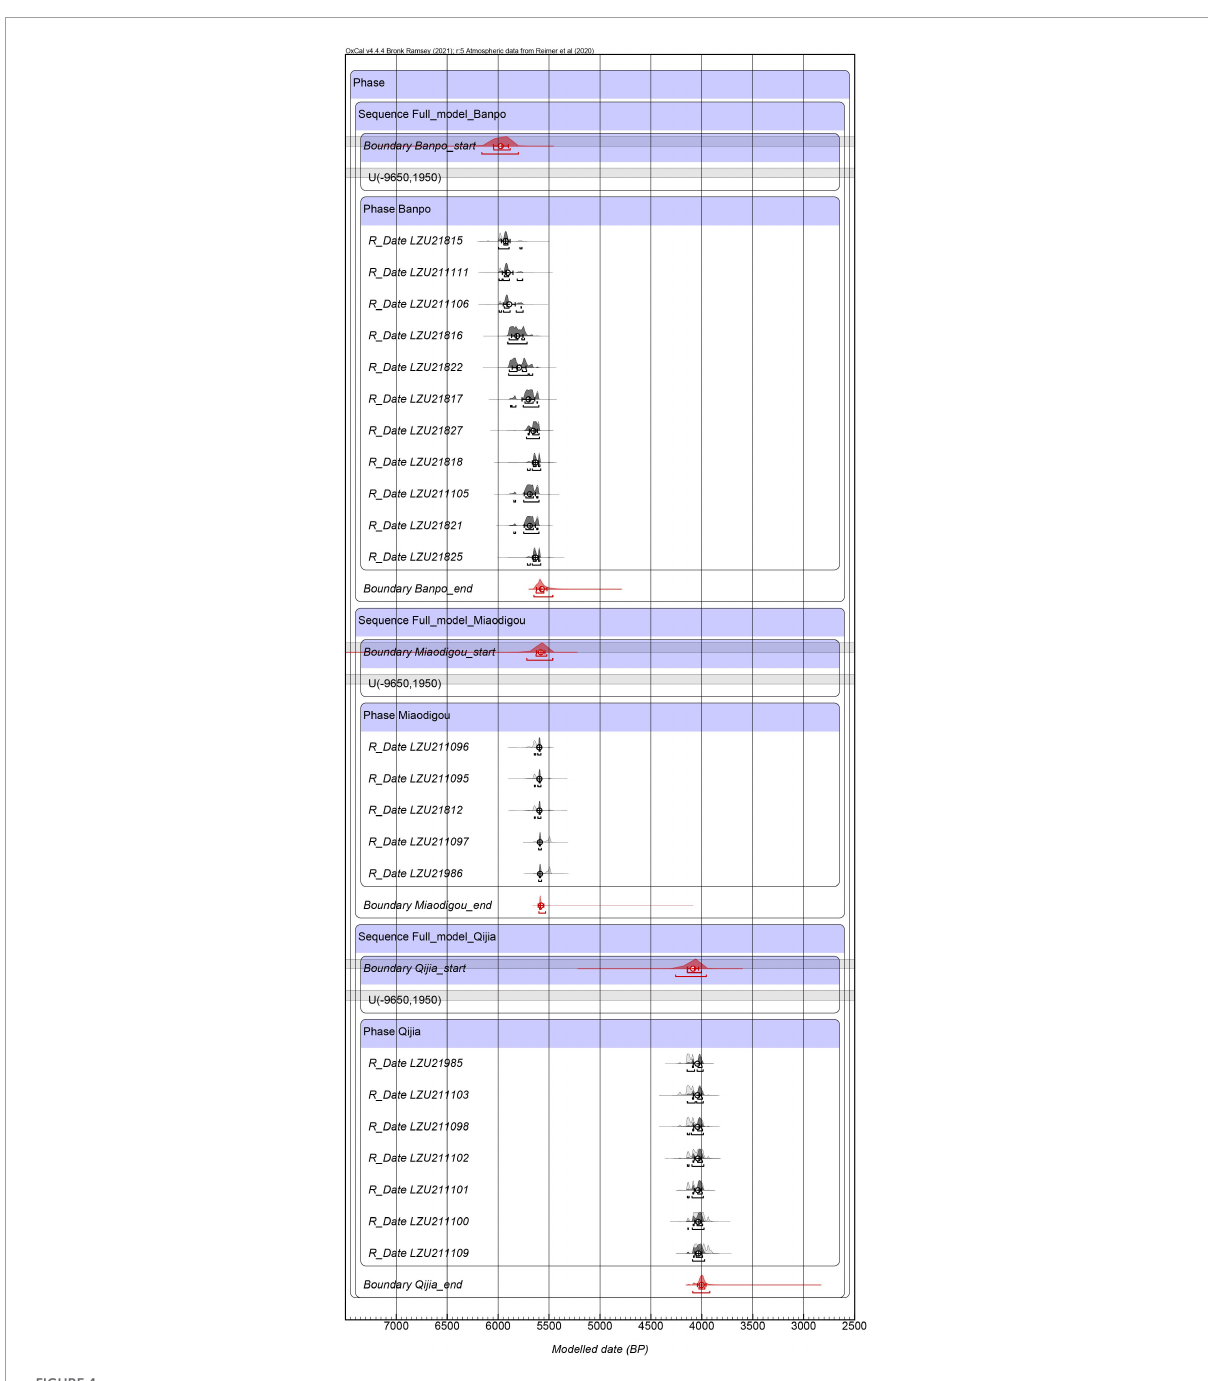
indicating an increasing trend of foxtail millet cultivation importance in subsistence agriculture over time. In addition, a few weed seeds were identified in the Banpo, Miaodigou and Qijia Culture periods, accounting for 0.38%, 1.21% and 0.34% of the identified plant seeds, respectively.